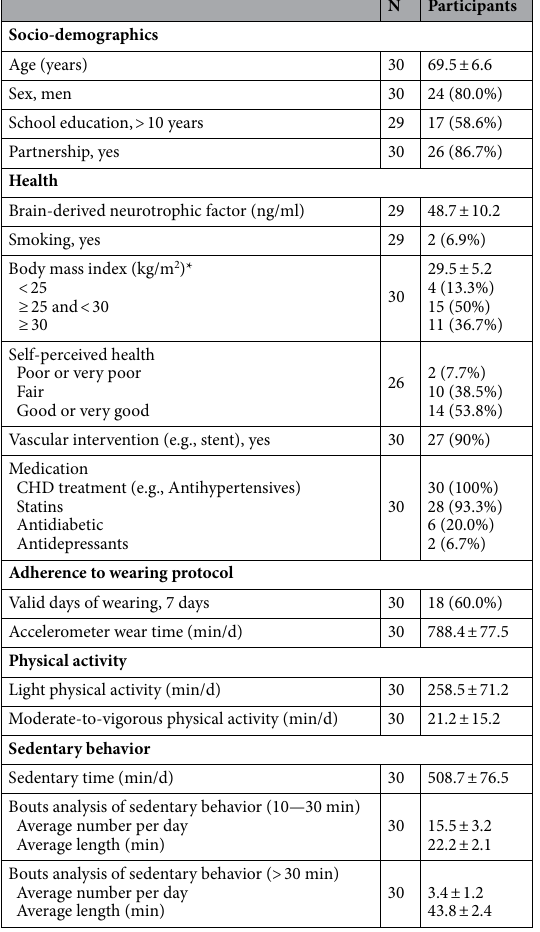
Table 2. Descriptive characteristics of the study sample (n = 30). CHD = Coronary Heart Disease. Data are presented as n (%) for categorical variables and mean ( M ) ± standard deviation ( SD ) for continuous variables, respectively. Data refer to the participants with valid accelerometer wearing days, only (≥ 4 days/ ≥ 10 h/d) (n = 30). * Body mass index was calculated as body weight divided by height squared (kg/m 2